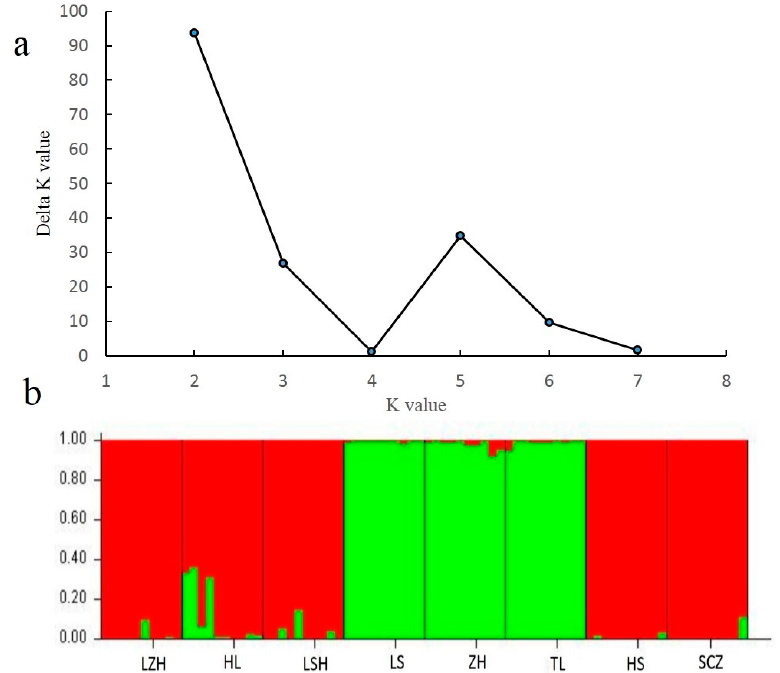
Figure 2. Results of STRUCTURE analysis for 80 individuals using 20 EST-SSR markers. ( a ) Estimation of population using Delta K value with cluster K ranging from 1 to 8. ( b ) Estimation of population structure based on STRUCTURE analysis.